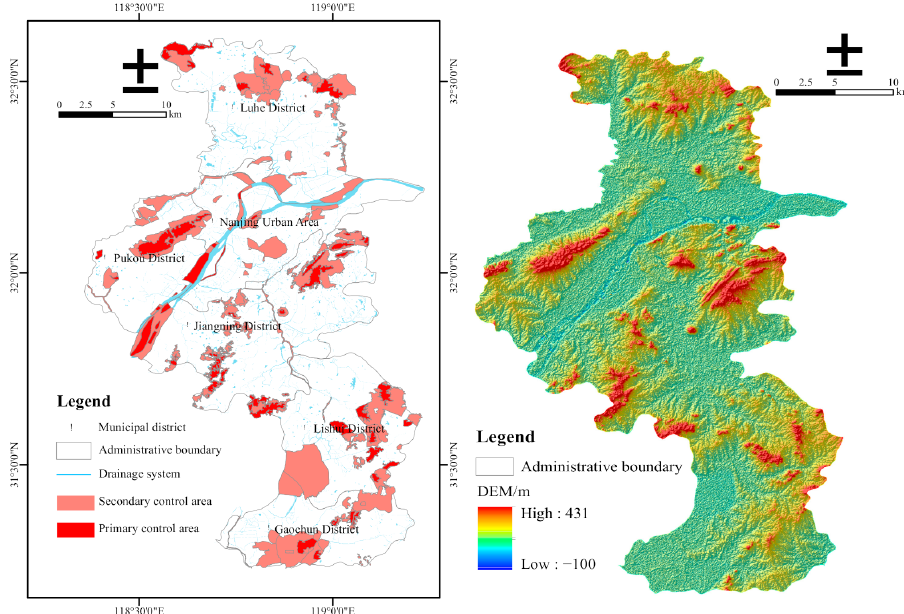
Figure 1. Regional distribution of the ecological red line and DEM rendering effect in Nanjing City.